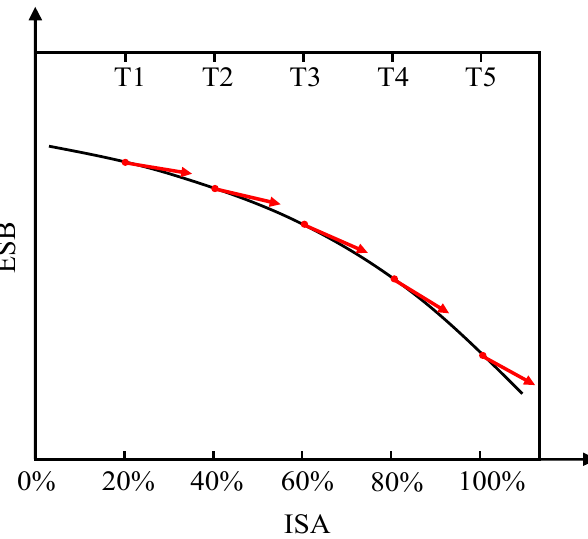
Figure 2. The theoretical curve of the impact of rapid urbanization on ESs trade-off and synergy (T represents the stage, the black line represents the relationship between ESB and ISA, and the arrow represents the change rate within the period.).